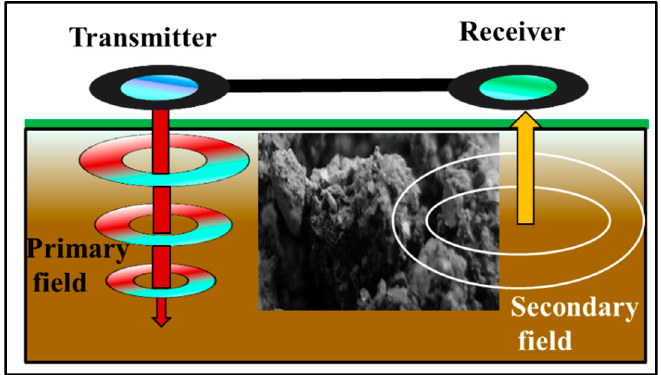
Figure 2. Schematic construction of the EM38 measurement principle (transmitter, receiver, primary and secondary field).